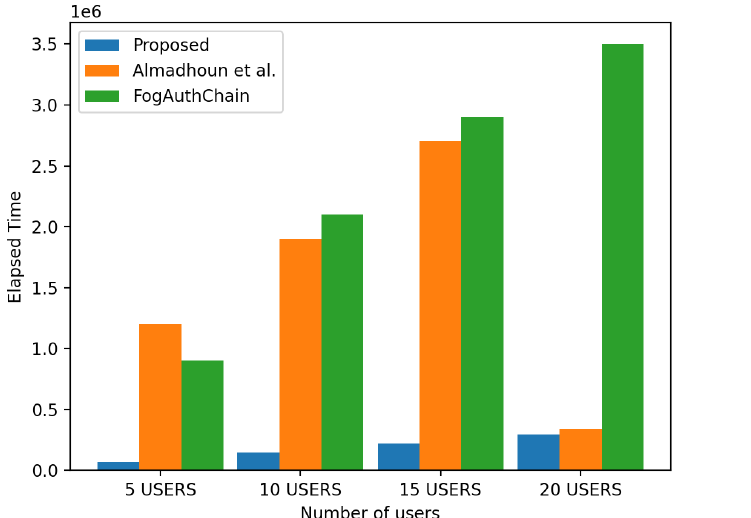
Figure 9. Simulation results showing the time required to send packets